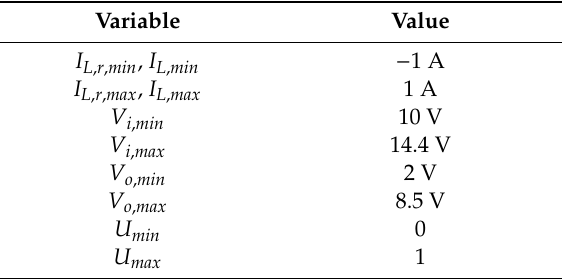
Table 2. Current subsystem marginal values.